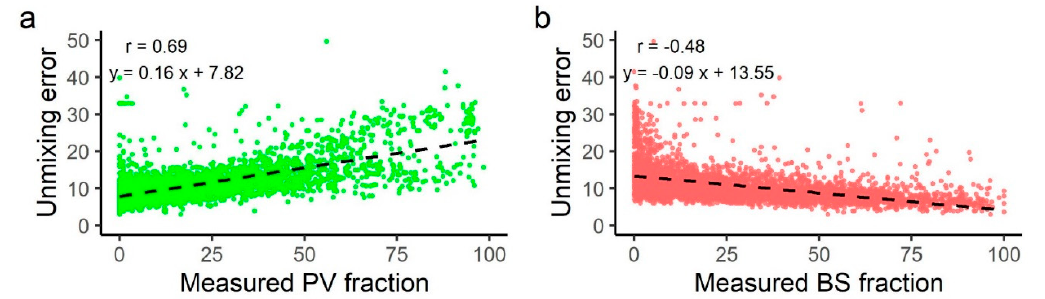
Figure A2. 2019 rainfall deciles in Australian continent. Source: Bureau of Meteorology (http://www.bom.gov.au/climate/history/rainfall/, accessed on 20 September 2022).